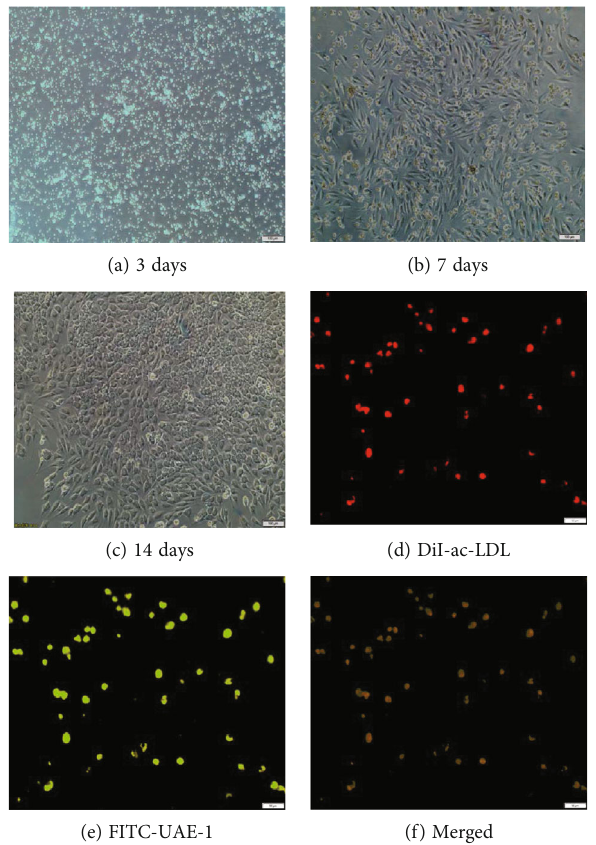
Figure 1: Morphological changes and identi fi cation of EPCs in bone marrow-derived mononuclear cells. (a) Round, adherent mononuclear cells were observed after 3 days of culture. (b) Colonies of mature, spindle-shaped EPCs were observed after 7 days of culture. (c) Mature EPCs with a typical cobblestone-like appearance and colony growth were observed after 14 days of culture. (a – c) Magni fi cation, × 100. (d – f) Magni fi cation, × 200. Mononuclear cells were isolated from rat bone marrow cells that (d) phagocytized DiI-ac-LDL dye and (e) were FITC- UEA-1 positive after 7 days of culture. (f) Overlay of images from panels (d) and (e) showing colocalization of DiI-ac-LDL dye and FITC- UEA-1 in the same cells. DiI-ac-LDL: 10-dioctadecyl-3,3,30,30-tetramethyl-indocarbocyanine-labeled acetylated fl uorescently labeled low- density lipoprotein; EPC: endothelial progenitor cell; UEA-1: Ulex europaeus